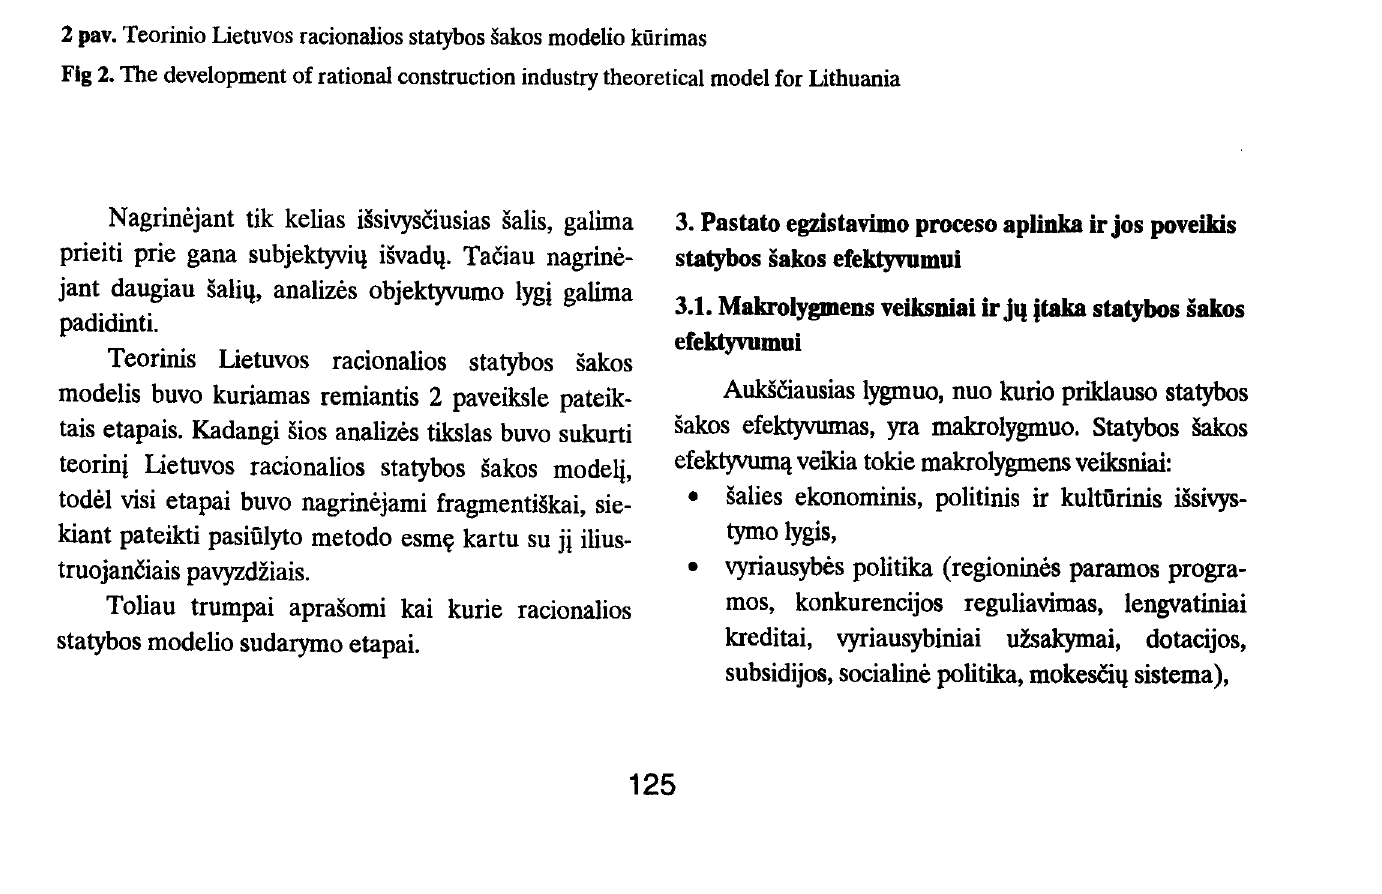
Fig 2. The development of rational construction industry theoretical model for Lithuania